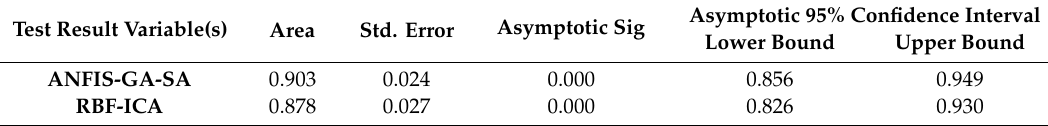
Figure 16. Result of the ROC curve. Table 7. Result of the area under the curve (AUC) for the two models.